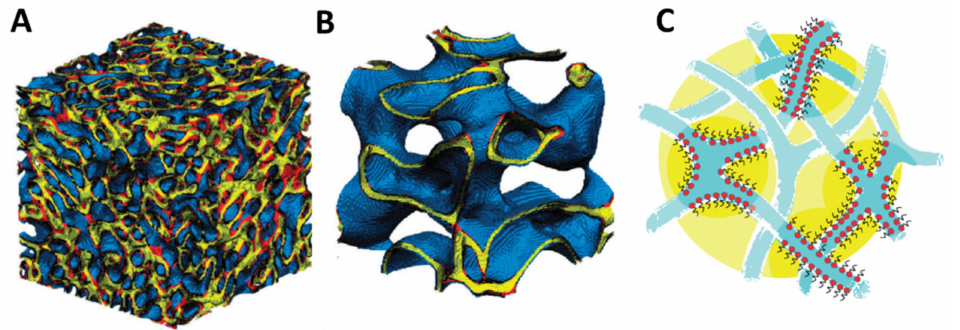
Figure 2. ( A , B ) Simulation of bicontinuous microemulsions ( µ E) with di ff erent compositions and rigidity. The side lengths of figures are 63 nm. For the illustrations, water is blue, oil is yellow, and the surfactant is red (only separation surfaces between the domains are represented. ( A ) Oil-rich (57% oil; 26% surfactant) flexible interface; ( B ) water-rich (21% oil, 15% surfactant) ultrarigid locally lamellar. Adapted from [13] with permission from the PCCP Owner Societies. ( C ) Pictorial description of a dilute, highly asymmetric bicontinuous water-in-oil (w / o) µ